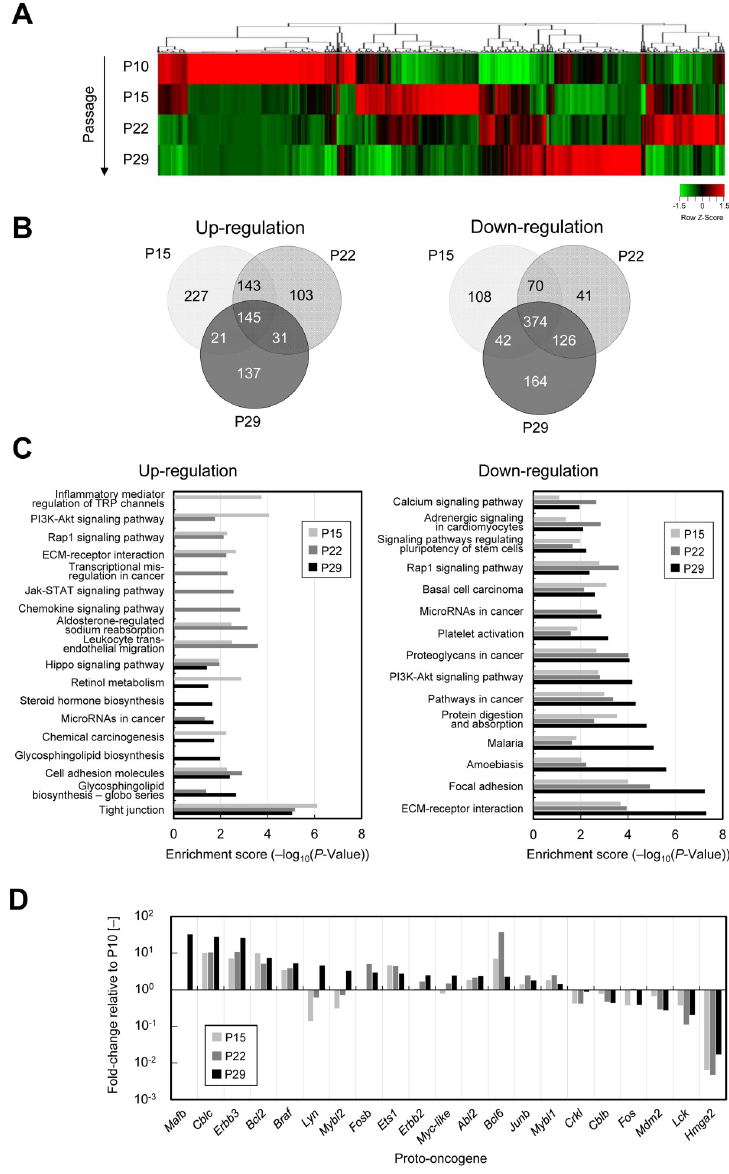
Fig 4. Gene expression analysis during the spontaneous immortalization process. (A) Heatmap analysis of gene expression in CHK cells during the immortalization process. Gene transcripts were prepared from CHK cells during culture at passages 10 (P10), 15 (P15), 22 (P22), and 29 (P29) after starting the primary culture. (B) Venn diagrams based on DNA microarray analysis. Differentially expressed genes were extracted according to changes of 2-fold or more and 0.5-fold or less, and a Z score of +2 or more and − 2 or less. The numbers shown in the Venn diagram indicate significantly upregulated and downregulated gene numbers compared with P10. (C) KEGG pathway analysis associated with the immortalization process. Enrichment scores ( − log 10 ( P -value)) for significant pathways in upregulated and downregulated genes extracted in (B) at P15, P22, and P29 compared with those of P10. (D) Differentially expressed genes of proto-oncogenes at P15, P22, and P29 in comparison to P10. upregulated genes, inflammatory mediator regulation and PI3K–AKT signaling of TRP chan- nel were extracted for P15, while the JAK–STAT and chemokine signaling pathways were extracted for P22, and the glycosphingolipid biosynthesis pathway was extracted for P29. Throughout the immortalization process, consistently high expression of tight junction-related